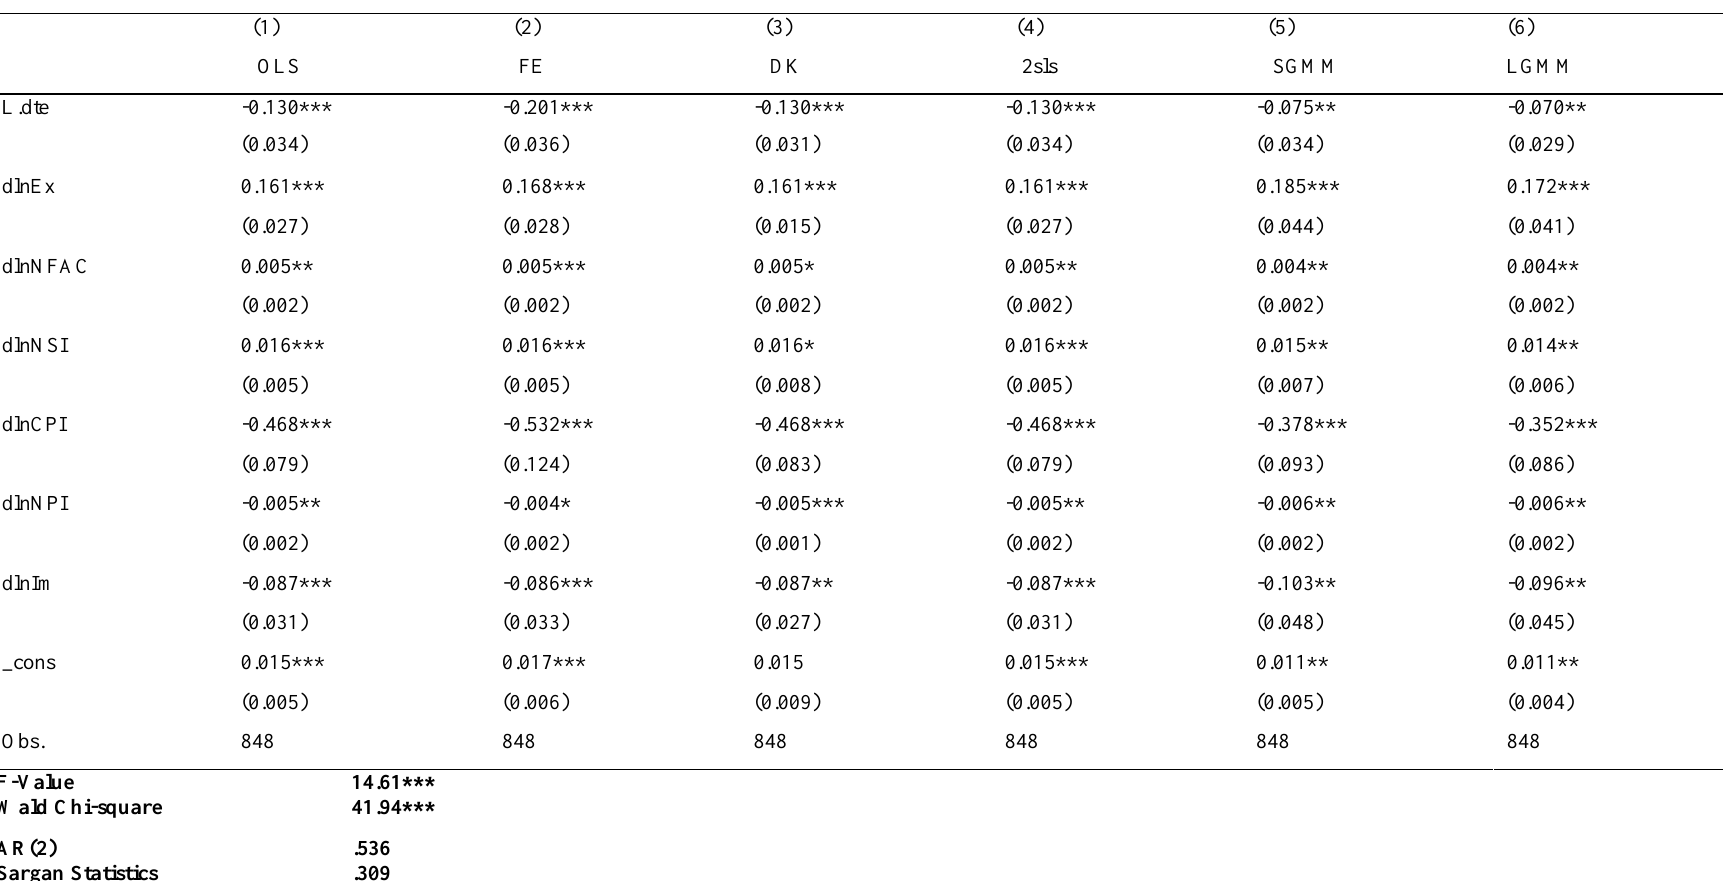
Table 10: Determinants of wealth maximizing technical efficiency for with GDPcu